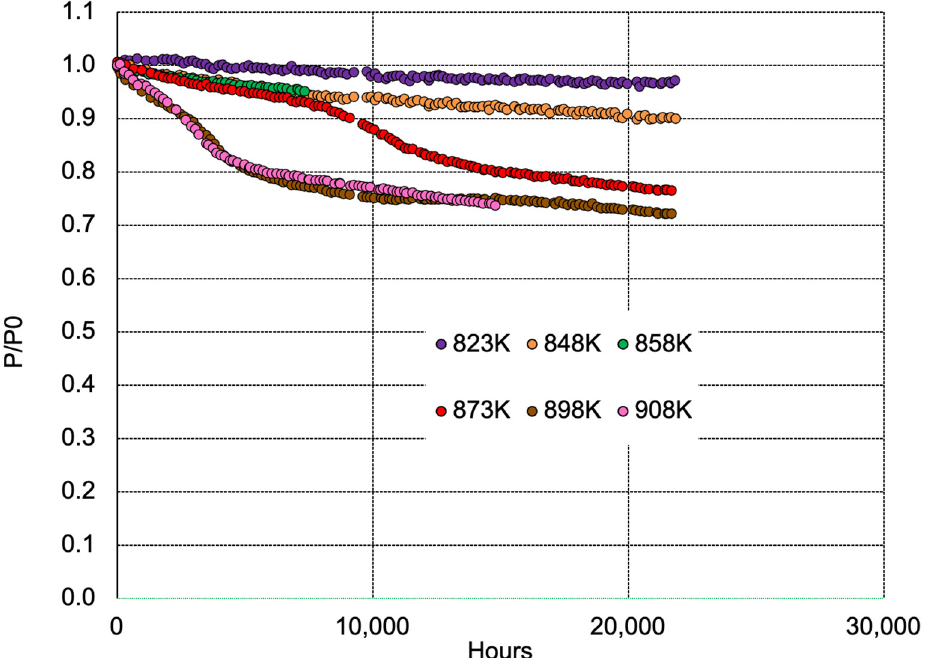
Figure 11. SKD couples normalized peak power as a function of time and temperature.